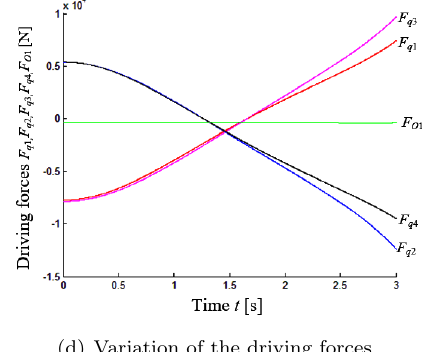
Table 5: The range of motion of the MP Description Value The range